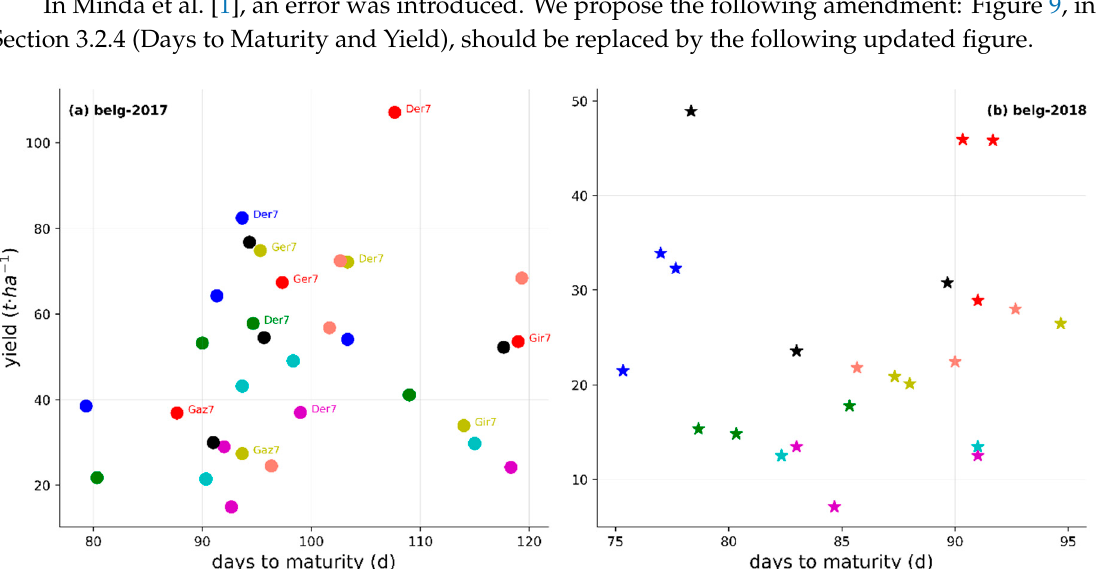
Figure 9. Variations in the observed yield (t · ha − 1 ) for the eight cultivars as a function of days to crop maturity (d). The colors represent cultivars in four locations (Gaz7—Gazesso, Ger7—Geresse, Der7—Derashe, and Gir7—Gircha) in belg -2017 ( a ) and six locations in belg -2018 ( b ). Note that the x and y-axes ranges are di ff erent for both panels; and the colors (e.g., red dots and line— Belete and yellow dots and line— Suthalo ) represent a cultivar in di ff erent farms.